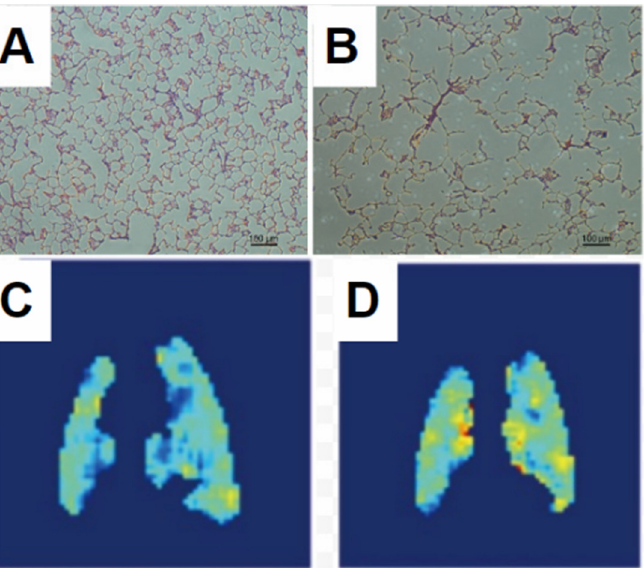
Figure 10. Instillation of the enzyme elastase into rat lungs ( B ) causes focal areas of tissue degradation and enlargement of the relatively uniform alveolar structures characteristic of the healthy lung ( A ). This enlargement can be visualized through ADC imaging (( C ), control); (( D ), elastase)) in which both the mean and standard deviation of diffusion distances are significantly increased. Adapted with permission from Wang, et al. ( Magn Reson Med 2018, ref. [42]), in which the full dataset shows that ADC and histological structural metrics are moderately correlated, and that appropriate thresholds separate the control and model animals using either measurement.